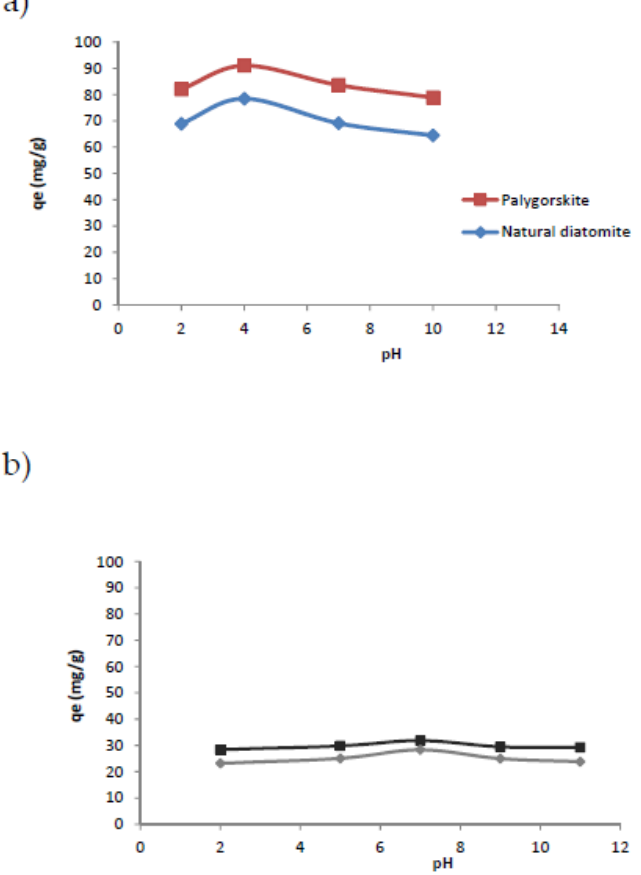
Figure 5. Effect of pH on the adsorption of Cu 2+ ( a ) and Ni 2+ ( b ) on diatomite and palygorskite (m adsorbent = 0.5 g, v = 300 rpm).